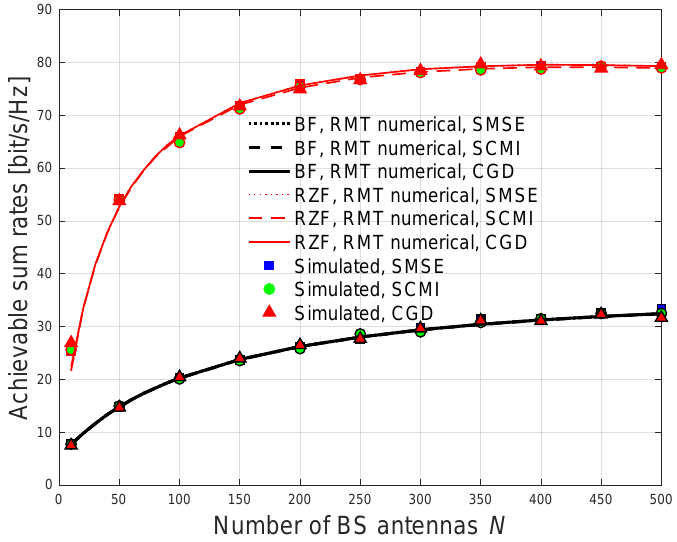
Figure 2. Achievable sum rate versus N , comparing different training designs with ω = 2.5 ◦ , D = 1/2.